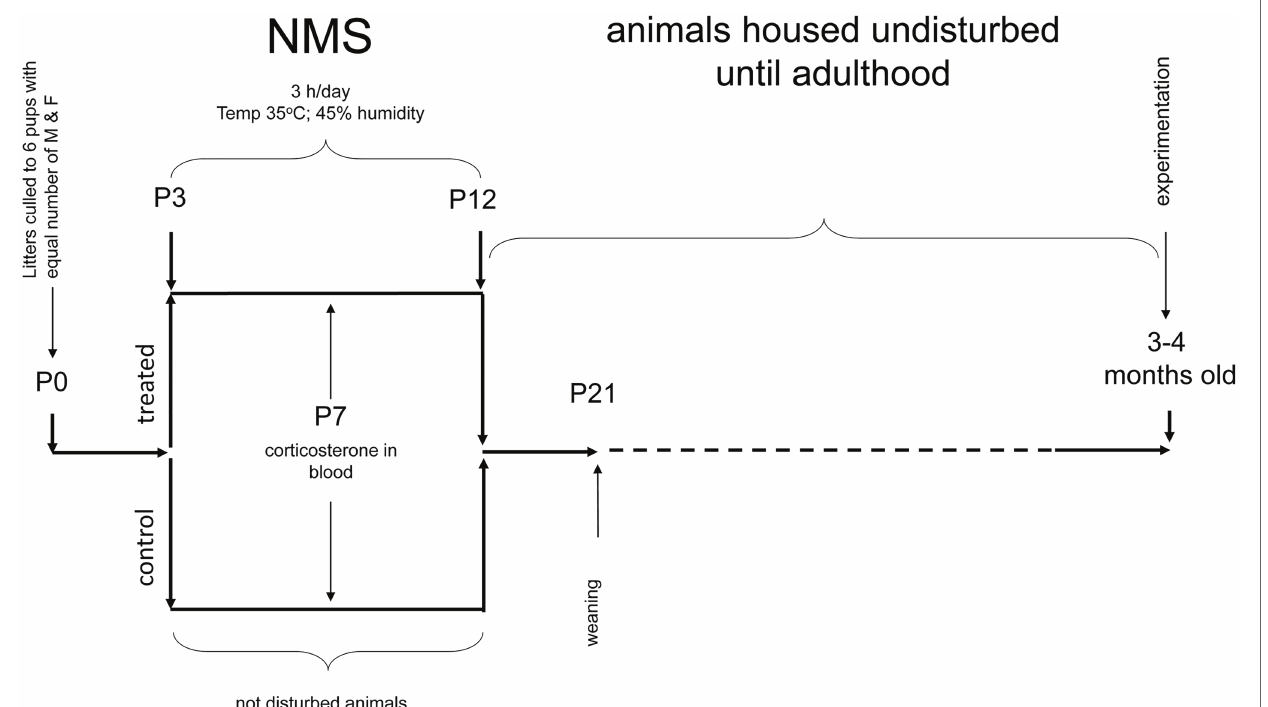
FIGURE 1 | Schematic representation of the neonatal maternal separation (NMS) protocol and evaluation of respiratory parameters in adults. WT and Tg21 animals were exposed to NMS between postnatal ages P3 and P12. Undisturbed animals during P3-P12 were used as control groups. Plasma corticosterone (CORT) levels were evaluated at P7 in a separate series of experiments. Resting breathing and in response to ventilatory stimuli were assessed when the animals reached adulthood (3–4 months